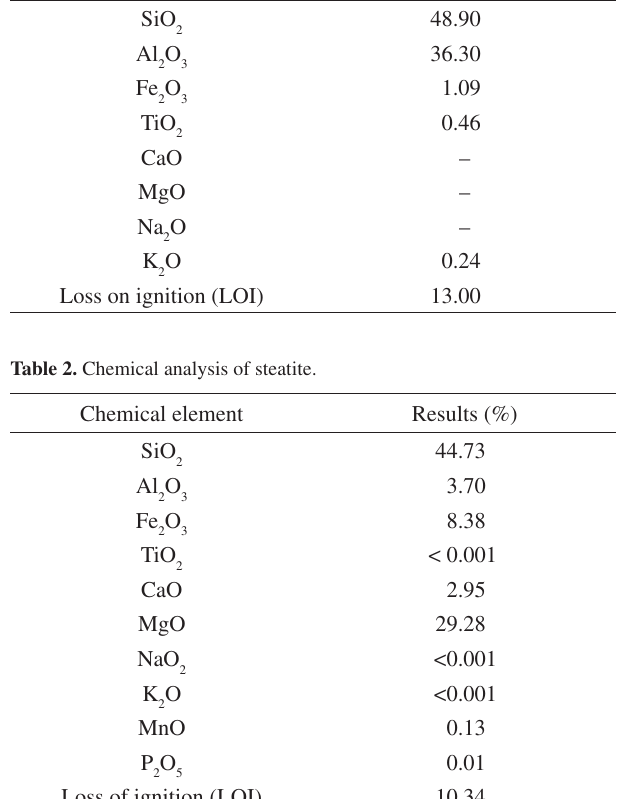
Table 3. Planning